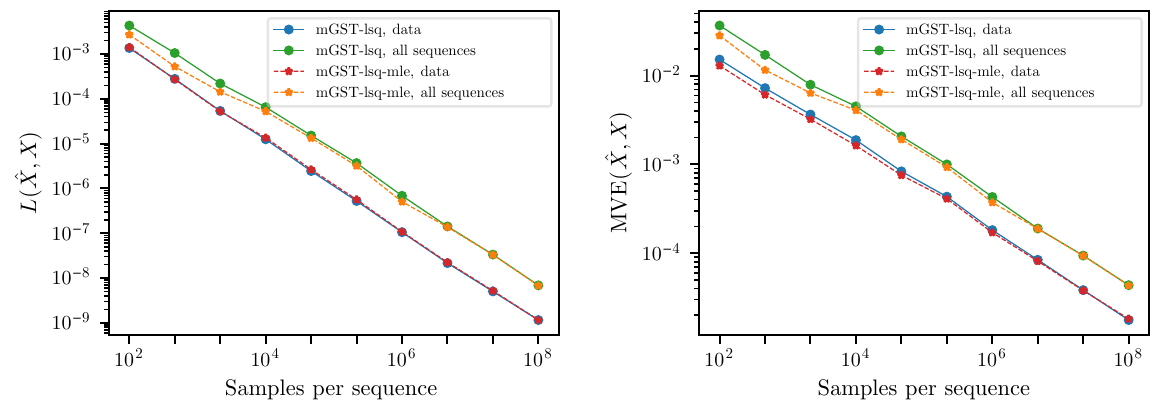
FIG. 9. Effect of optimizing the loglikelihood function after the least-squares objective function. The results of only the least-squares optimization are denoted by mGST -lsq and those of additional loglikelihood optimization by mGST -lsq-mle. The left plot shows the ˆ X , X ) on the data sequences (used for estimation), as well as on all sequences of a given length least-squares objective function L ( l (here l = 7). The right plot uses the MVE, again on data sequences or all sequences. The underlying gate set is given by the XYI model with depolarizing noise of strength p = 0.01 on each gate and p = 0.01 on the initial state, as well as random unitary rotations e i γ H with H ∼ GUE and γ = 0.01 on each gate. To ensure that mGST -lsq is fully converged, we set the desired relative precision to (cid:10) = 10 − 5 in the convergence criterion, see Eq.